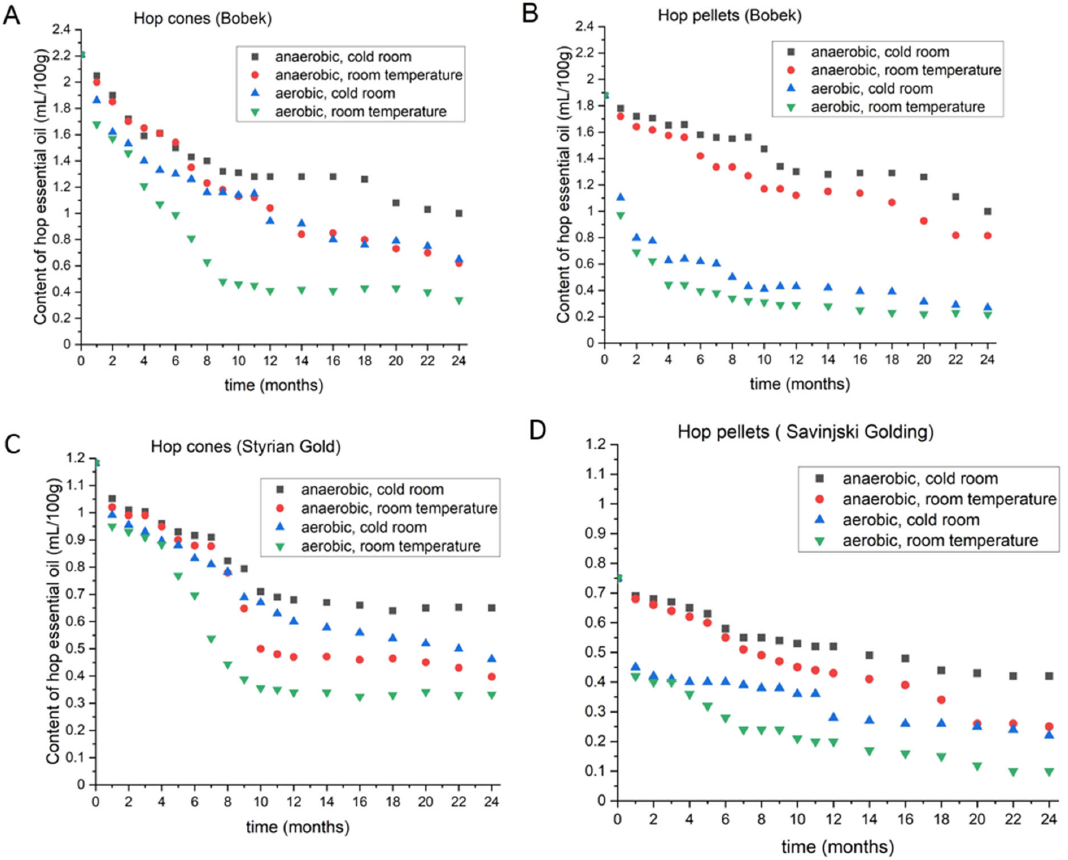
Figure 2. Changes in the content of hop essential oil in Bobek cones ( A ) and pellets ( B ), Styrian Gold ian Gold cones ( C ) and Savinjski Golding pellets ( D ) during two-year period, under different cones ( C ) and Savinjski Golding pellets ( D ) during two ‐ year period, under different storage condi ‐ storage tions.